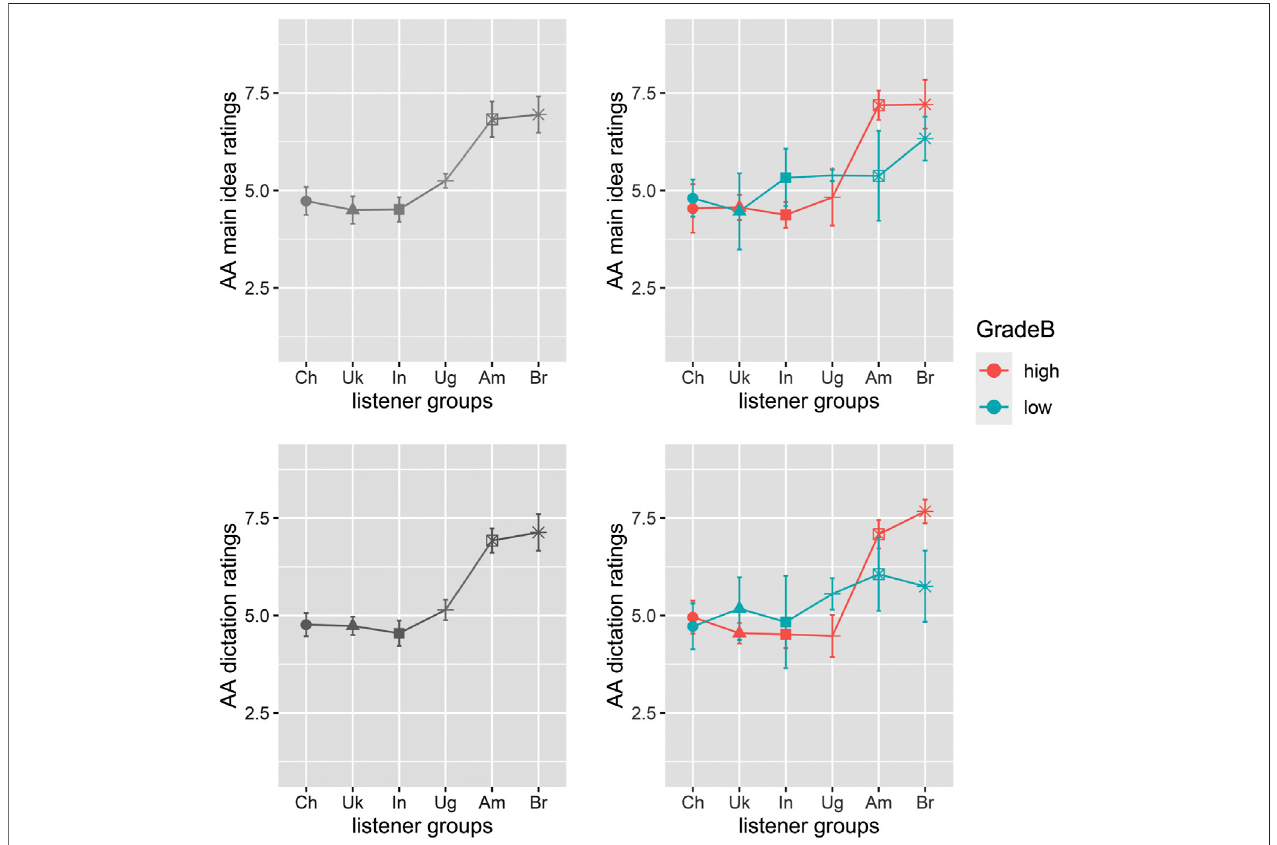
FIGURE 4 | Accentedness acceptance groups (left) and groups*English grades (right) plots using 20% trimmed means and standard errors: Note. Subject numbersare:Ch (cid:1) 23(high (cid:1) 10andlow (cid:1) 13),Uk (cid:1) 26(high (cid:1) 17andlow (cid:1) 9),In (cid:1) 27(high (cid:1) 24andlow (cid:1) 3),Ug (cid:1) 29(high (cid:1) 14andlow (cid:1) 15),Am (cid:1) 26(high (cid:1) 20and low (cid:1) 6), Br (cid:1) 29 (high (cid:1) 19 and low (cid:1) 10).